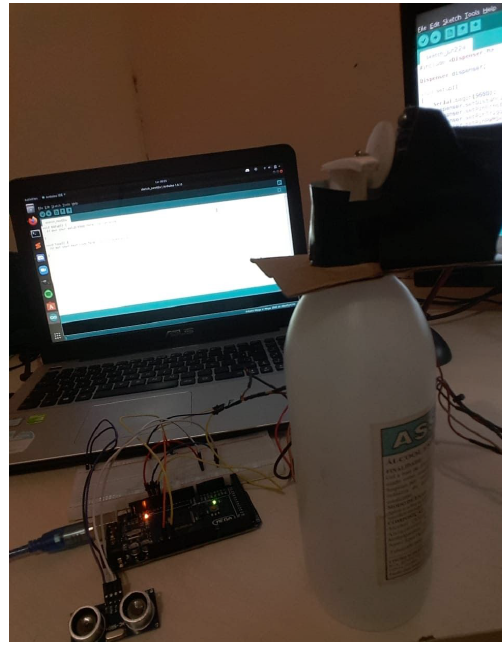
Figure 8. Smart Dispenser